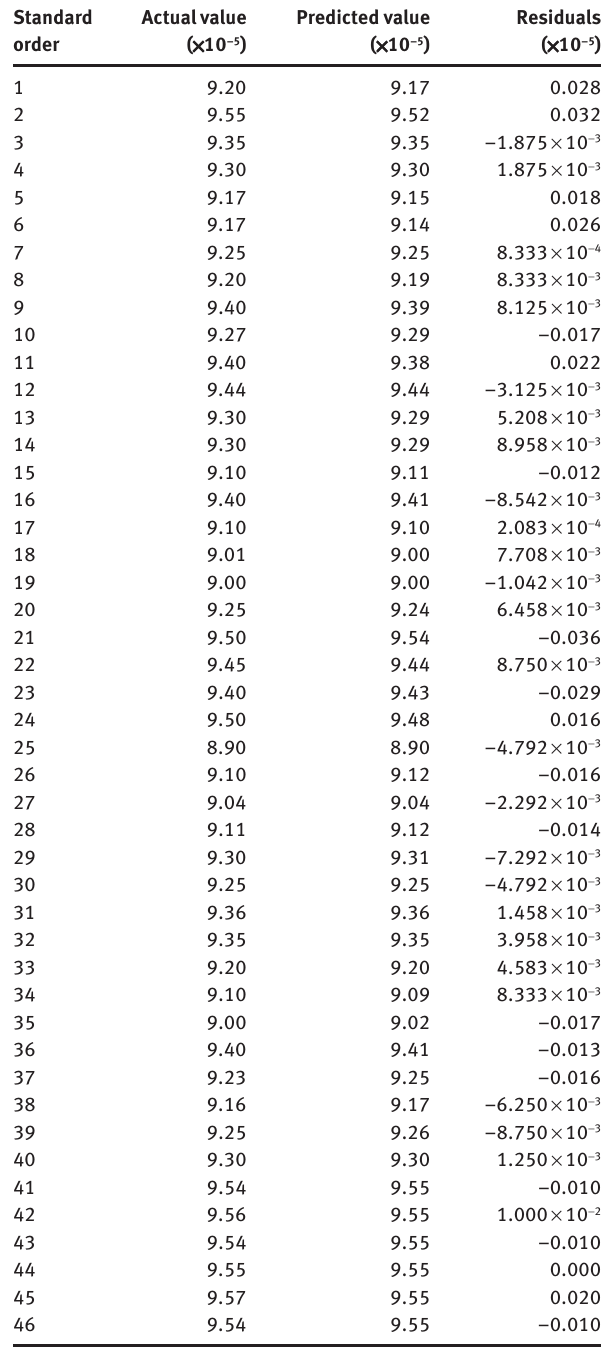
Table 5: Diagnostics case statistics.